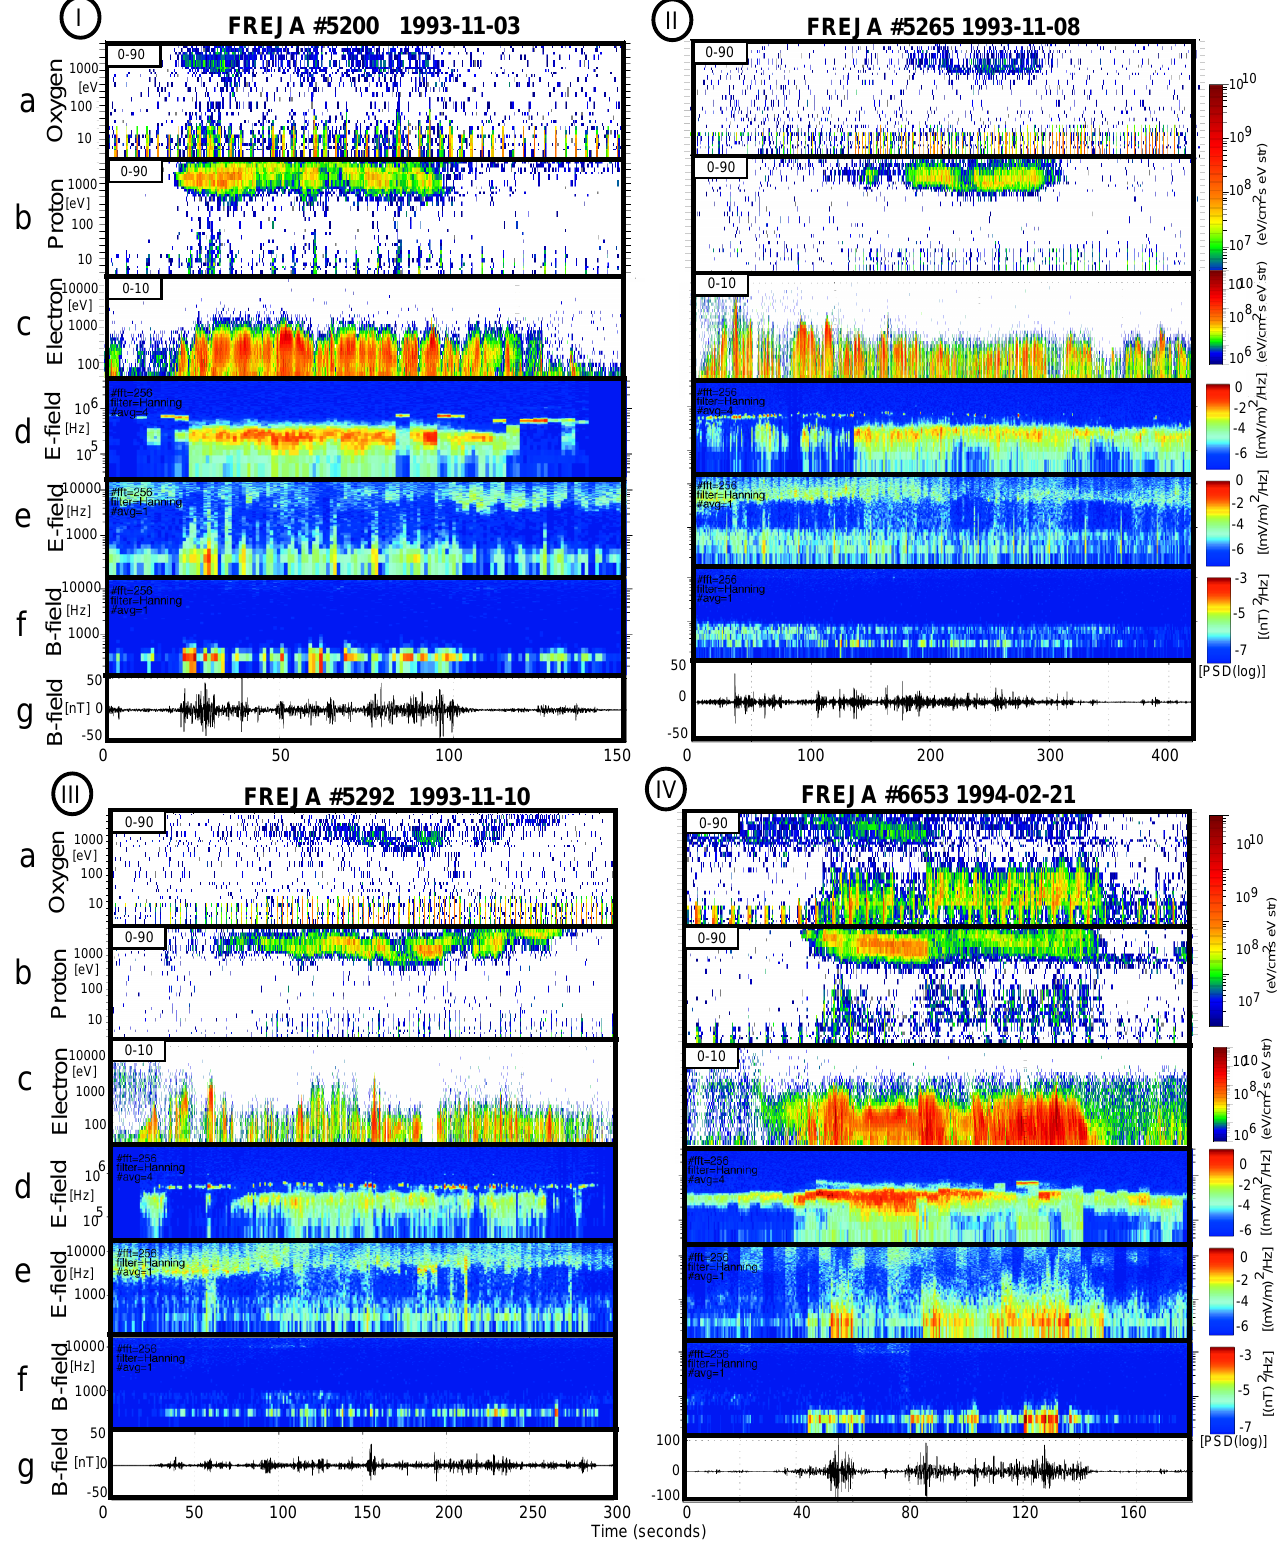
Fig. 1. Overview data from four Freja satellite passes of the northern dayside auroral region. The panels display from the top; O + (TICS), H + (TICS), field-aligned downward moving electrons (TESP), HF electric wave components (F4), MF electric and magnetic wave components (F4), and the AC magnetic field (F2),